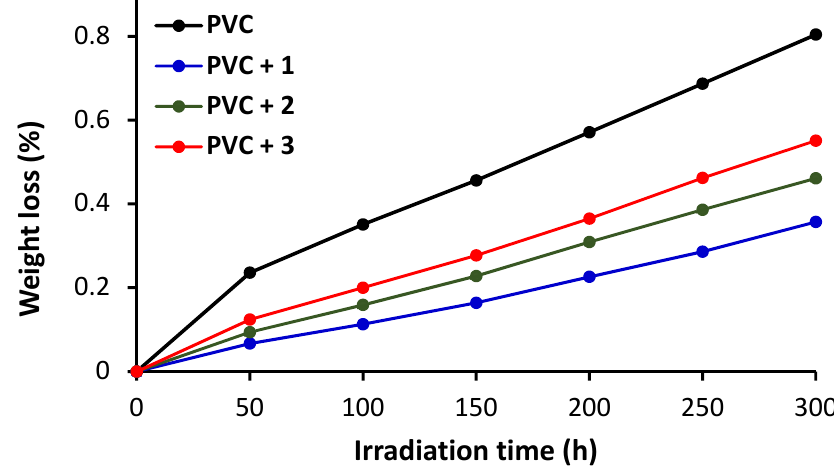
Figure 4. Changes in weight loss (%) of PVC films during irradiation.